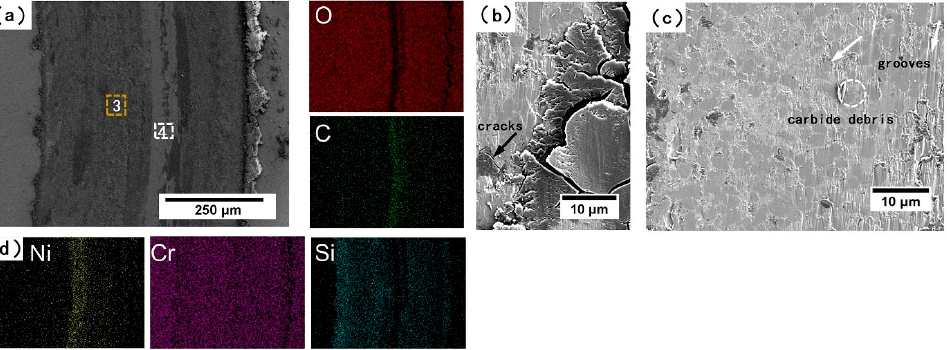
Figure 10. ( a ) Surface morphology of the 192 h - annealed coating after wear test at RT; ( b , c ), high- magnification images of the selected regions marked by 3,4 in ( a ); ( d ) EDS elemental mapping of Ni, Cr, Si, C and O of ( a ).